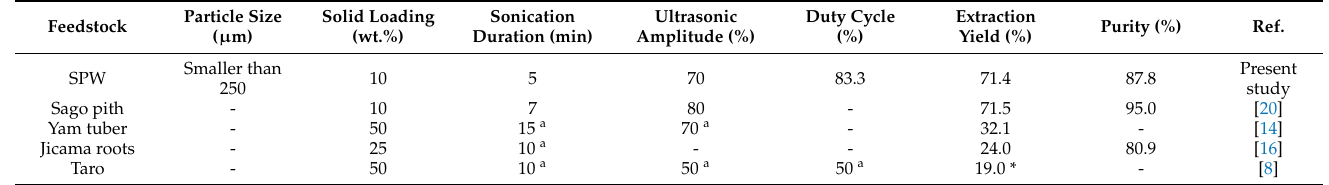
Table 2. Comparison of optimum reaction conditions for ultrasound-assisted starch extraction in various studies.